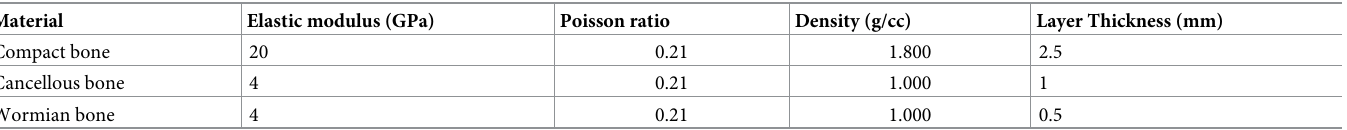
Fig 6. a) Idealised FE model representing the three-layered structure of the skull under 3-point bending, b) without Wormian bone, where a layer of spongy cancellous bone is sandwiched between to cortical layers, and c) including Wormian bone, where a Wormian layer is included as an additional undulating layer within the upper table of cortical bone. https://doi.org/10.1371/journal.pone.0249451.g006 Table 1. Mechanical properties for idealised FE skull bone models [32].